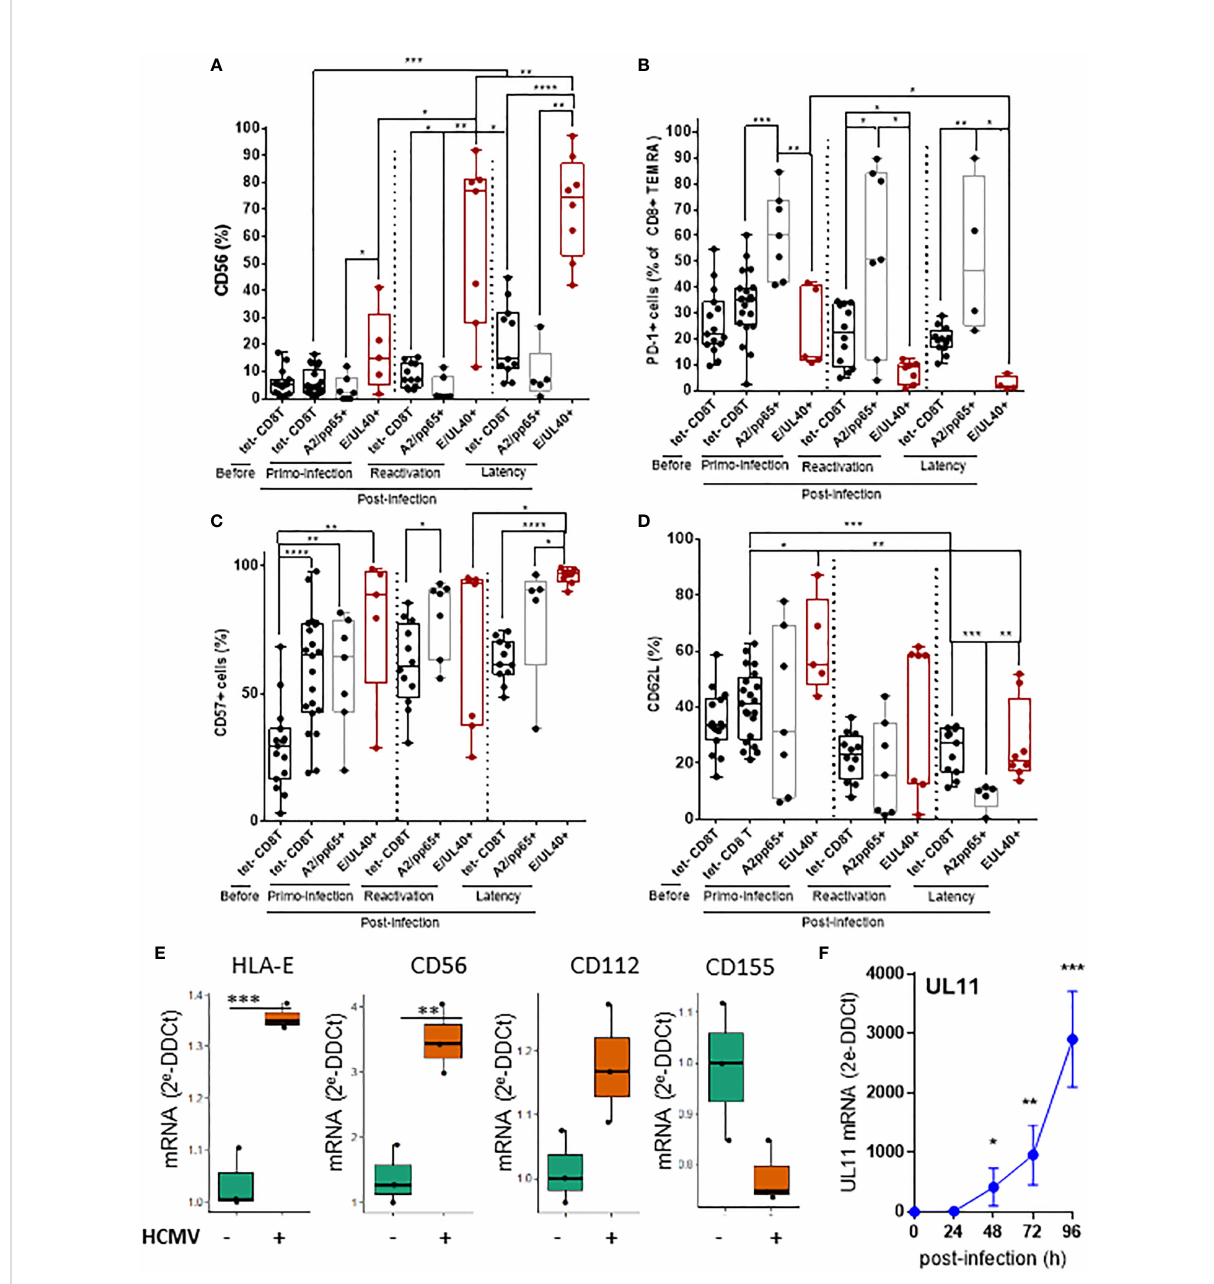
FIGURE 4 T cell markers discriminating HLA-E- from HLA-A2-restricted HCMV-speci fi c CD8T cells and expression of related ligands on HCMV infected cells. After immunostaining and fl uorescence acquisition, CD8Tcell populations were de fi ned using a dedicated gating strategy as reported in the FigS3 in order to identify pMHC tetramer - CD8Tcells (tet-CD8T), HLA-E UL40 (E/UL40+) and HLA-A2 pp65 (A2/pp65+) CD8Tcells. (A – D) Box plots with median and interquartile values for analyses performed on HLA-E UL40 CD8T cells from KTR with a primary infection (n=5), a reactivation (n=7), HV (n=9) and on HLA-A2 pp65 CD8T cells from KTR with a primary infection (n=7), a reactivation (n=7), HV (n=10) and the respective tet - CD8T cells. Speci fi c expression for CD56 (A) , PD-1 (B) , CD57 (C) , and CD62L (D) are shown. Results are expressed as percents of positive cells in the different CD8Tcell subsets. Each point corresponds to an individual CD8T response. Statistical analysis was performed by Mann-Whitney U -test. (E, F) Quantitative variations in mRNA levels for cellular (E) HLA-E, CD56, CD112, CD155 and viral (F) UL11 in primary human endothelial cell cultures after HCMV infection. Results from qRT-PCR are means ± SD obtained from 5 independent endothelial cell cultures and are expressed as 2- DD Ct values normalized to the RPLP0 housekeeping gene.R and the web application FaDa (https://github.com/ danger-r/FaDAapp) were used for (E) . Statistical analysis was performed by Mann-Whitney U-test. P values: * for p < 0.05, ** for p<0.01, *** for p<0.005 and **** for p<0